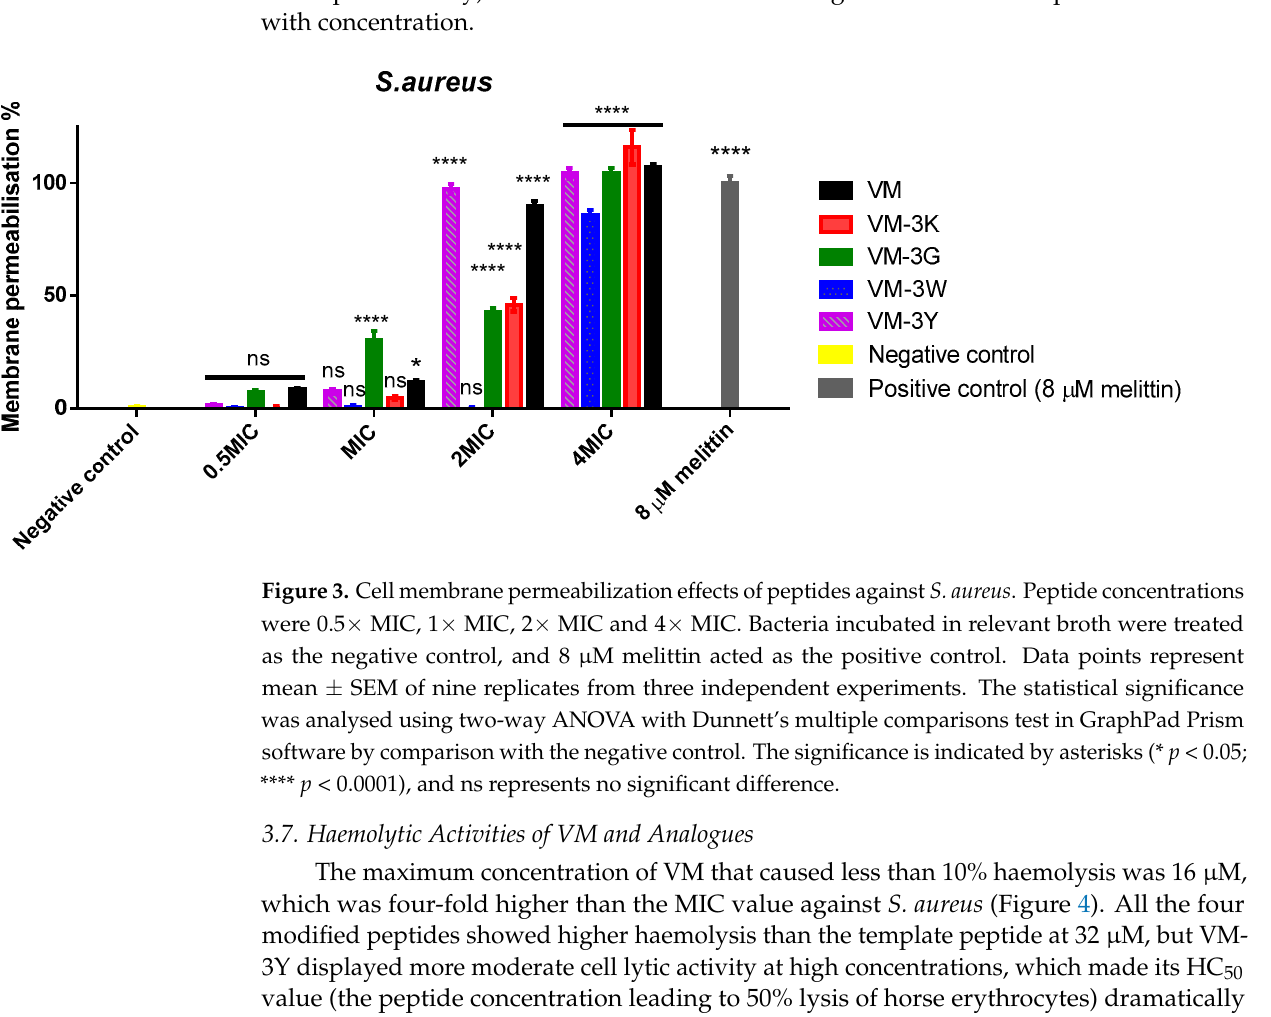
Figure 2. Bacterial killing kinetics of five VM peptides that have potent antibacterial ability against S. aureus . ( a ) The bacterial killing kinetics of VM; ( b ) The bacterial killing kinetics of VM-3K; ( c ) The bacterial killing kinetics of VM-3G; ( d ) The bacterial killing kinetics of VM-3W; ( e ) The bacterial killing kinetics of VM-3Y. The bacteria were treated with peptides for 180 min at concentrations corresponding to 1× MIC and 2× MIC. The bacteria treated with broth only were used as growth controls. Data points represent mean ± standard error of means (SEM) of nine replicates from three independent experiments.